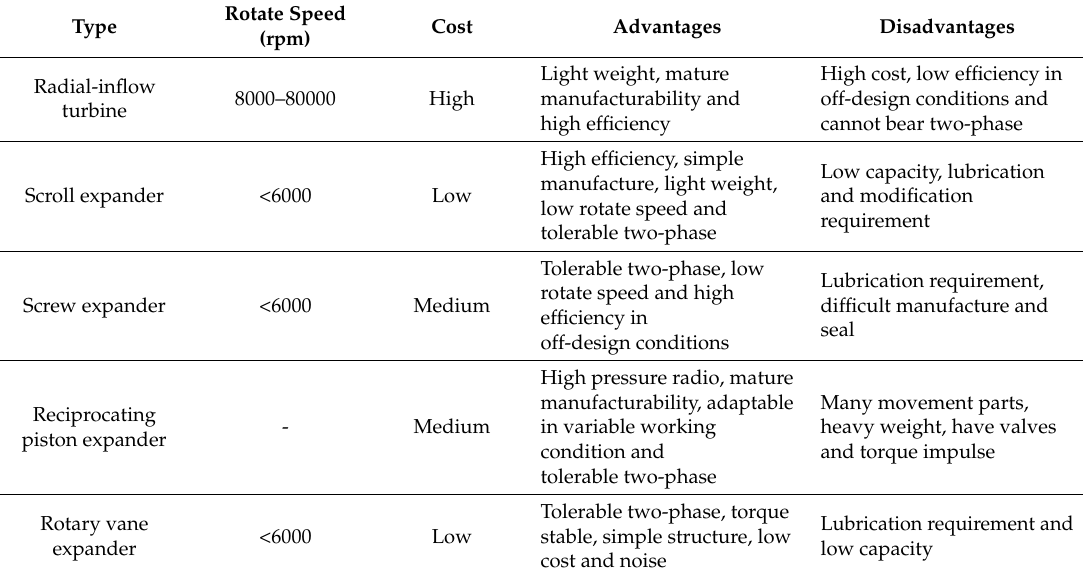
Table 6. Information data about the turbines [69].